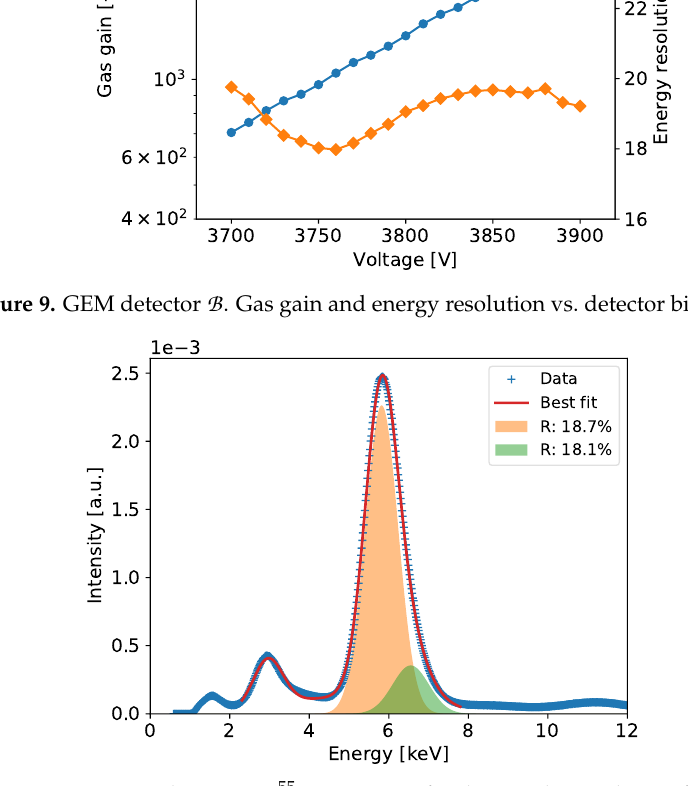
Figure 10. GEM detector B . 55 Fe spectrum for detector bias voltage of